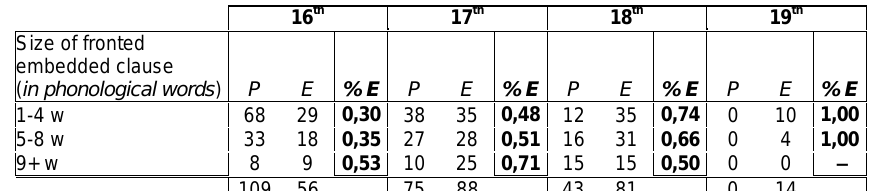
Table 2b : Length of pre-verbal clauses and clitic placement (16 th to 19 th centuries) 16 th 17 th 18 th 19 th Size of fronted embedded